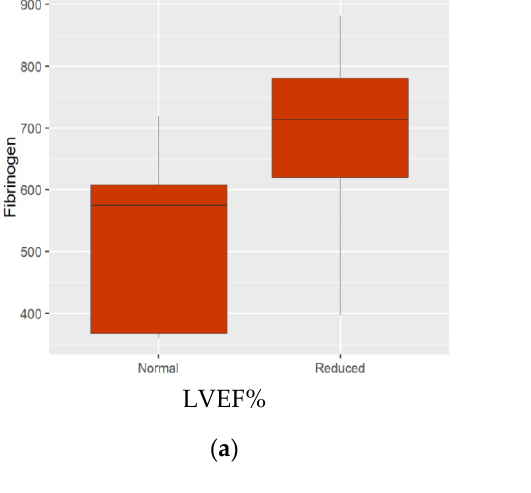
Figure 2. ( a ) Fibrinogen levels significantly higher in reduced LVEF group. ( b ) Trend of LVEF, according to NT-pro-BNP levels. LVEF: left ventricular ejection fraction; IQR: interquartile range; NT-pro-BNP: N-terminal prohormone of brain natriuretic peptide.